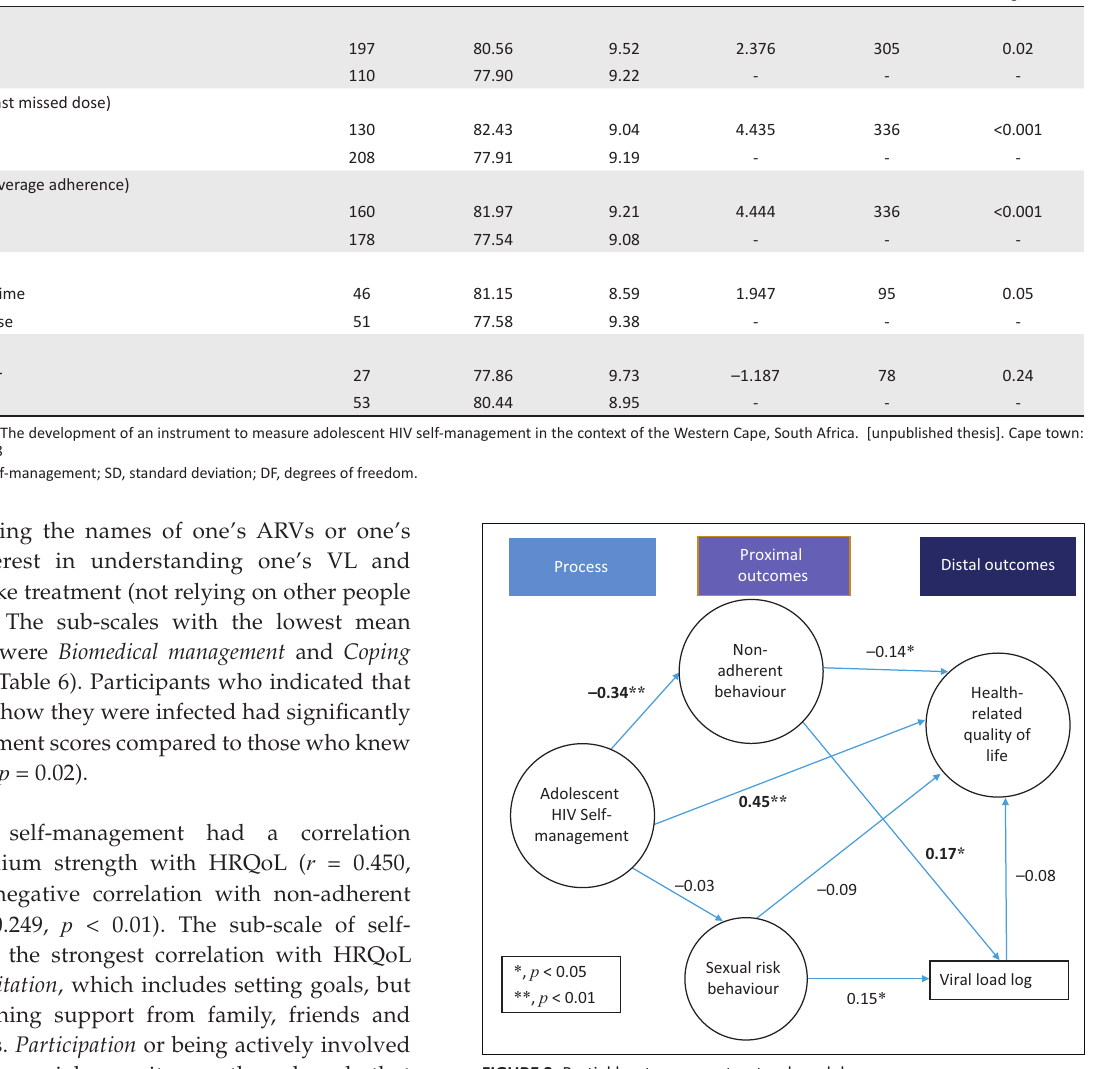
TABLE 7: Independent t -tests for adolescent HIV self-management across categories of viral suppression and adherence. AdHIVSM-35